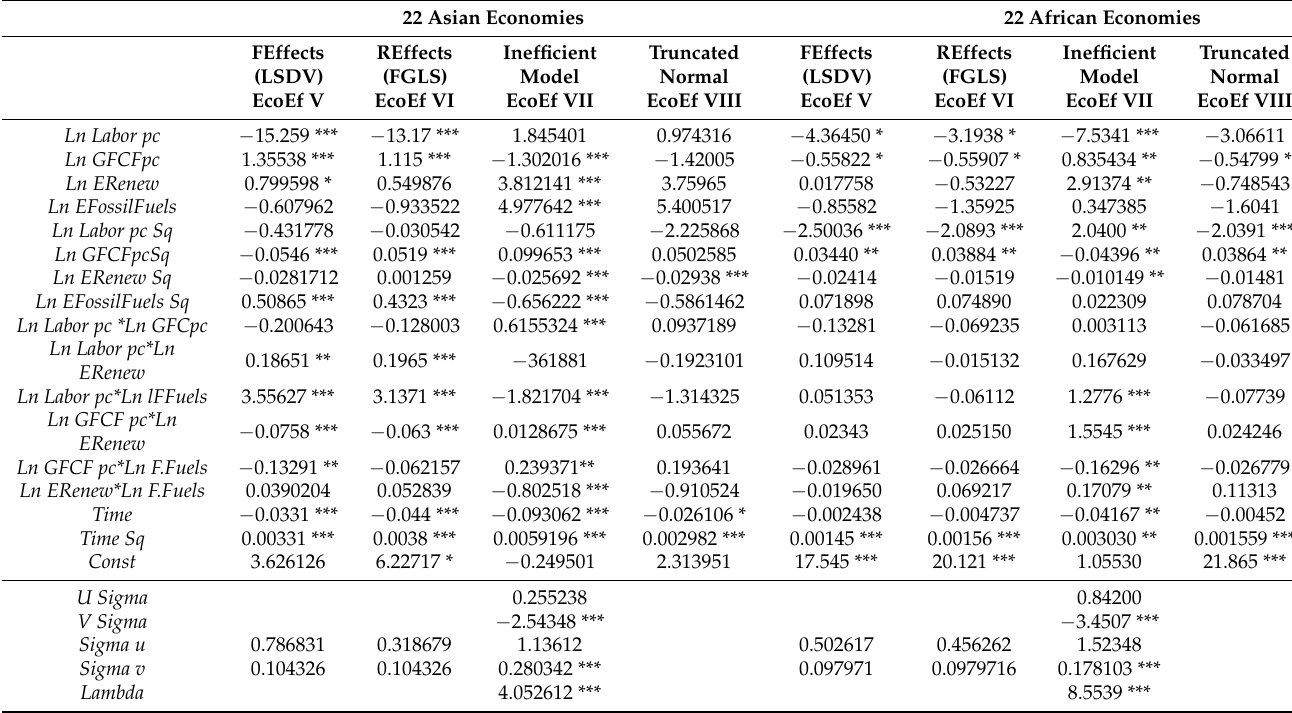
Table 2. Translog estimation results for Eco-efficiency with time-invariant models (22 Asian countries and 22 African